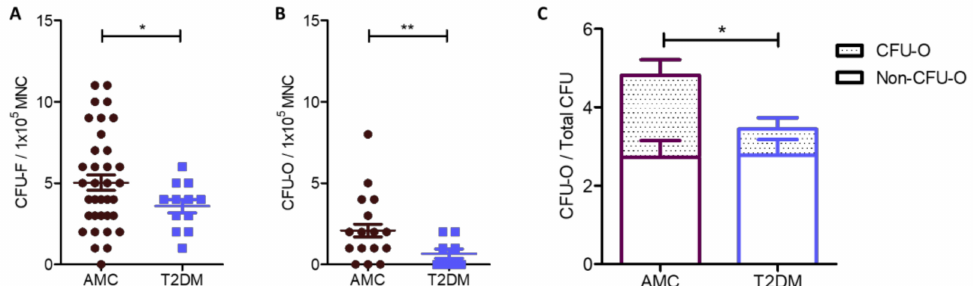
Figure 1. Quantification of the number of MSCs, detected as CFU-Fs, and those MSCs with native osteogenic potential (CFU-O) within whole marrow aspirates from AMC and T2DM cohorts. ( A ) Bone marrow from donors living with T2DM ( n = 39) contained reduced numbers of CFU-Fs compared to bone marrow from the AMC cohort ( n = 12). These data were normalised to MNC number and indicate the number of MSCs in the bone marrow is reduced in response to the T2DM environment. ( B ) CFU-O numbers in fresh bone marrow were identified by alkaline phosphatase staining and normalised to MNC number as per CFU-F. A reduction in the number of CFU-Os was recorded in the bone marrow in the T2DM cohort ( n = 9) compared to that from the AMC cohort ( n = 22). ( C ) In evaluating CFU-O number as a proportion of all CFUs in a donor bone marrow by two-way factorial analysis of deviance, diabetic status was observed to lead to a reduction in the proportion of CFU-Os. All data are displayed as mean ± SEM. * = p ≤ 0.05; ** = p ≤